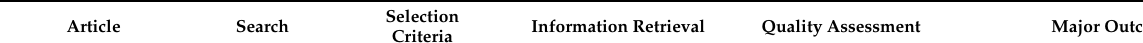
Table 1. Table showing the eligible papers for analysis of vaccine hesitancy n =